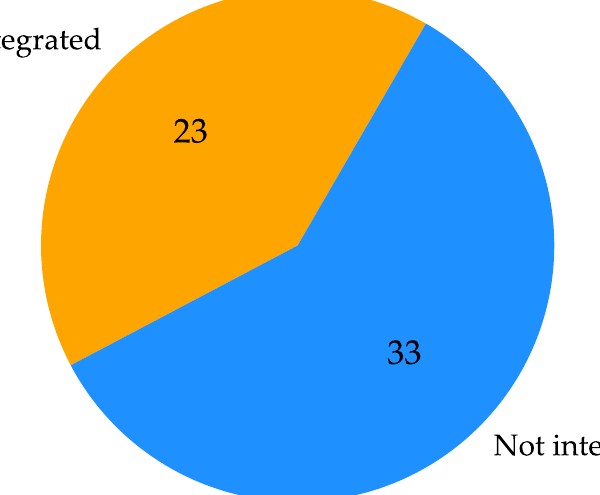
Figure 9. Number of projects per integration.